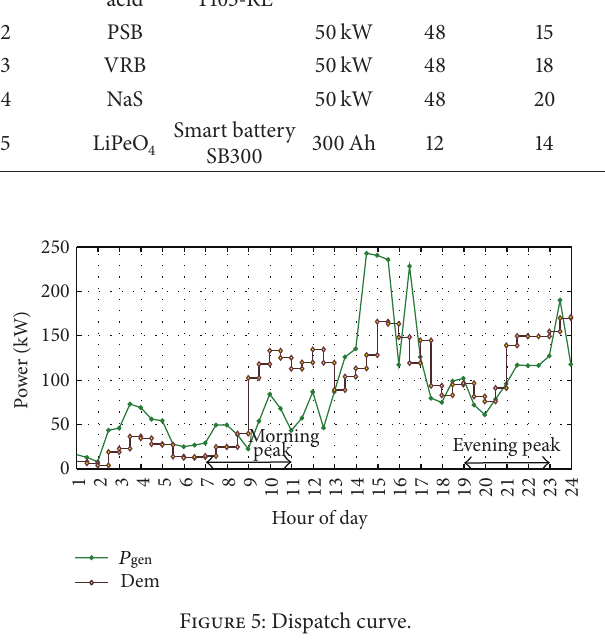
Figure 5: Dispatch